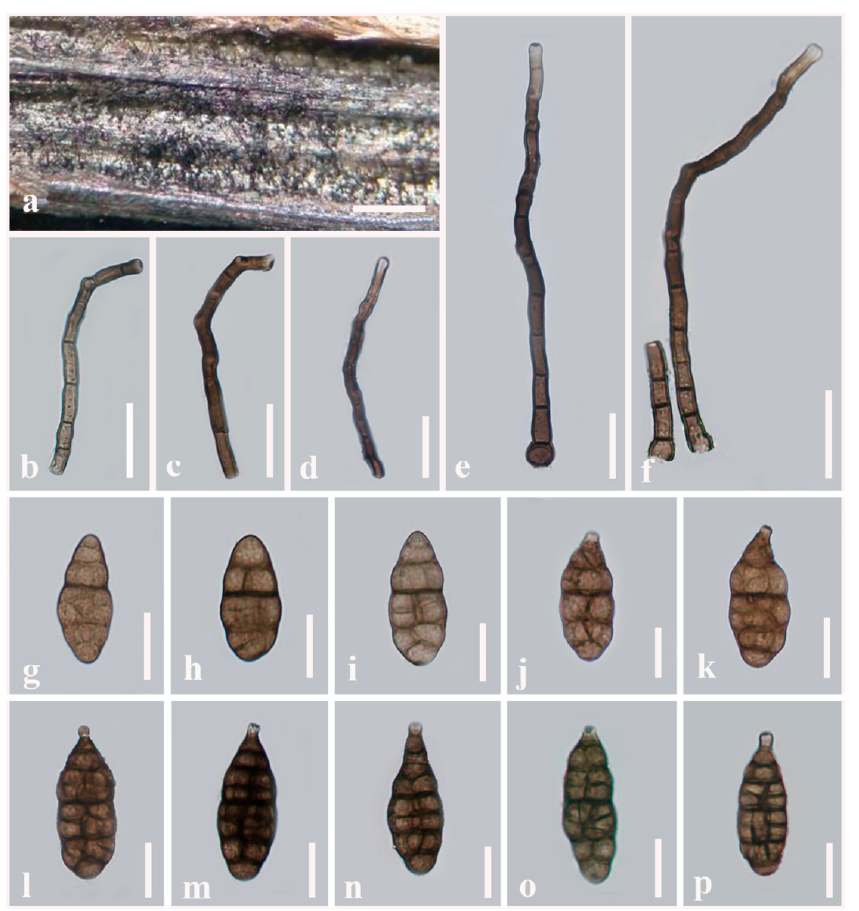
Figure 2. Alternaria muriformispora (MFLU 21-0309, holotype). ( a ) Colonies on dead aerial stem of Plantago sp. ( Plantaginaceae ); ( b – f ) Conidiophores bearing conidiogenous cells; ( g – p ) Conidia. Scale bars: ( a ) = 100 µm, ( b – f ) = 50 µm, ( g , j – p ) = 30 µm, ( h , i ) = 20